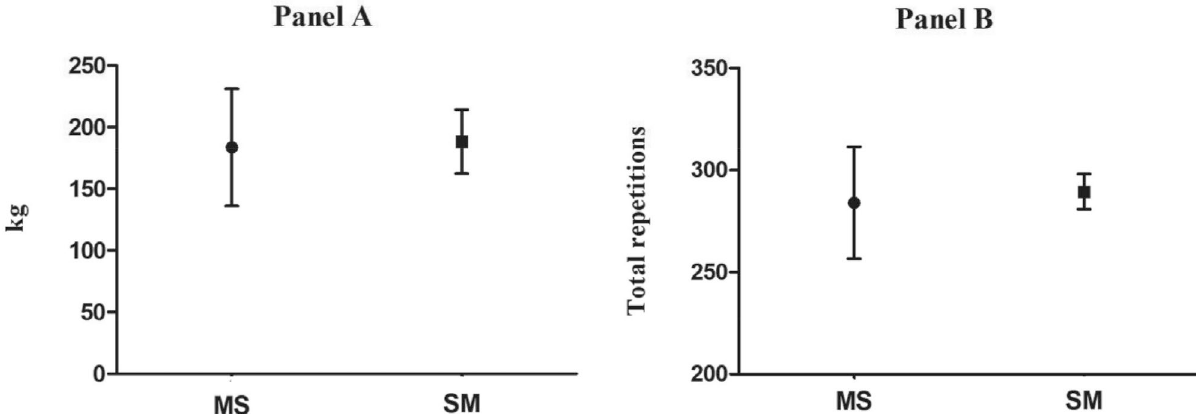
Figure 2 - Total load in kg (panel A), and total repetitions (panel B) of the groups. MS = group that performed RT from multi- to single-joint exercises; SM = group that performed RT from single- to multi-joint